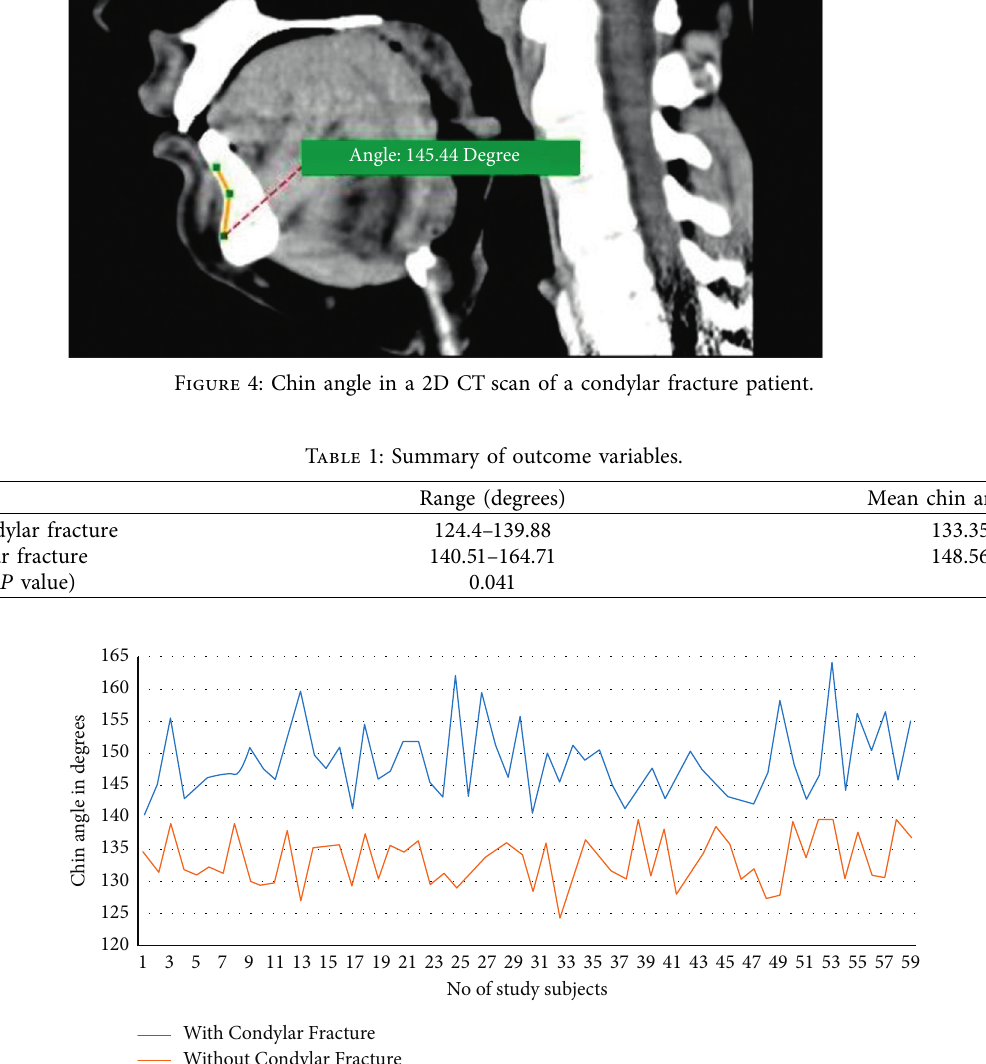
Figure 5: Comparison of chin angles in condylar fracture and noncondylar fracture